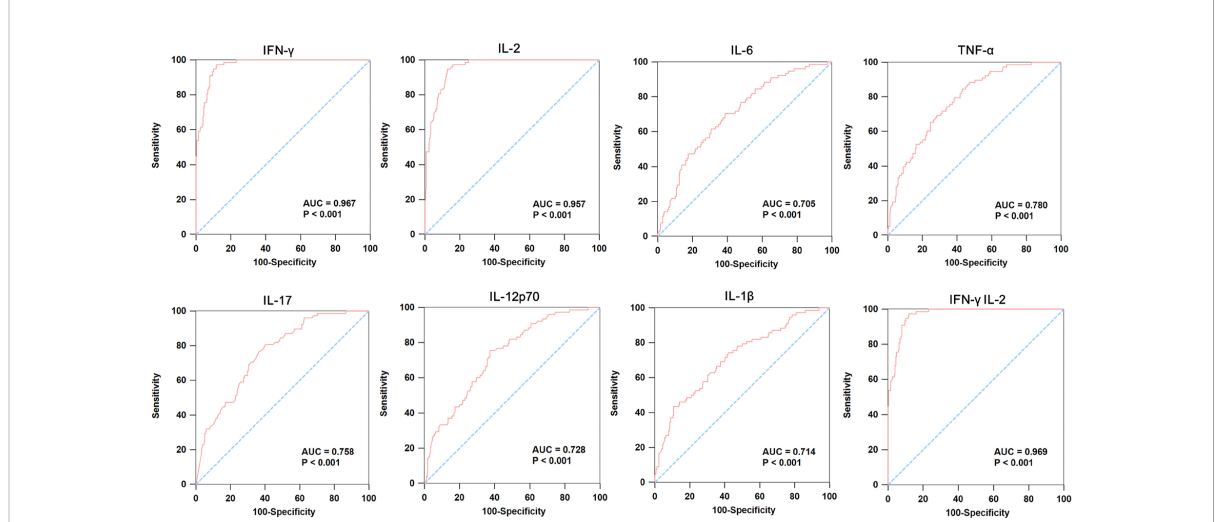
FIGURE 2 ROC curve analysis of cytokines in individuals with latent TB infection and IGRA-positive TB patients compared to healthy control and IGRA- negative TB patients. We combined LTBI and IGRA-positive TB patients as Group I, and healthy control and IGRA-negative TB patients as Group II. Then, we did the ROC curve to analysis the expression of IFN- g , IL-2, IL-6, TNF- a , IL-17, IL-12p70, IL-1 b and IFN- g &IL-2 in these two